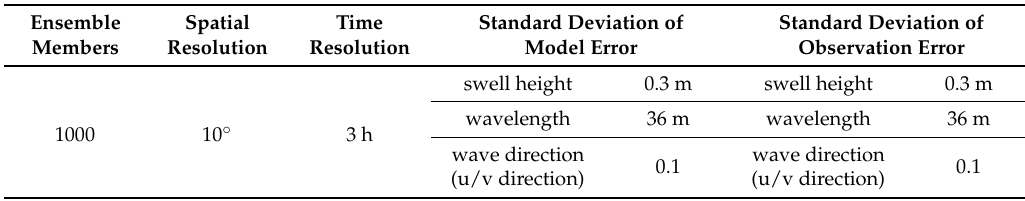
Table 2. EnKF parameters for the control experiment.